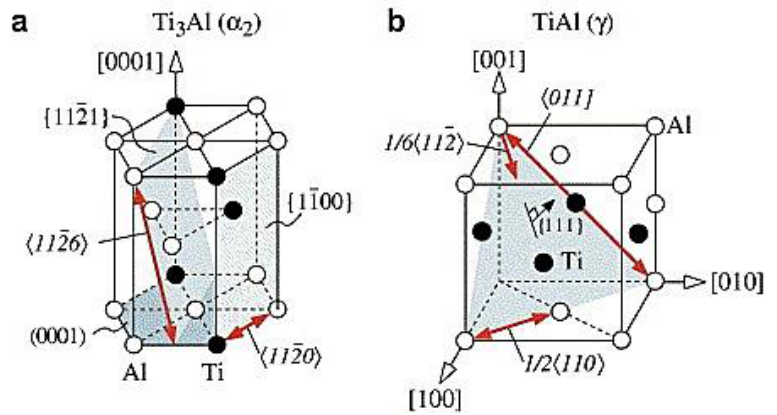
Figure 9. Titanium aluminide (TiAl) crystal structures, reproduced from [94], with permission from Elsevier, 2007.